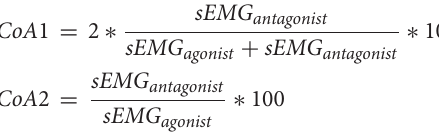
TABLE 1 | Descriptive data presented as number (n) or as mean deviation (SD) for the different groups. N 11 23 Unilateral right/left/bilateral